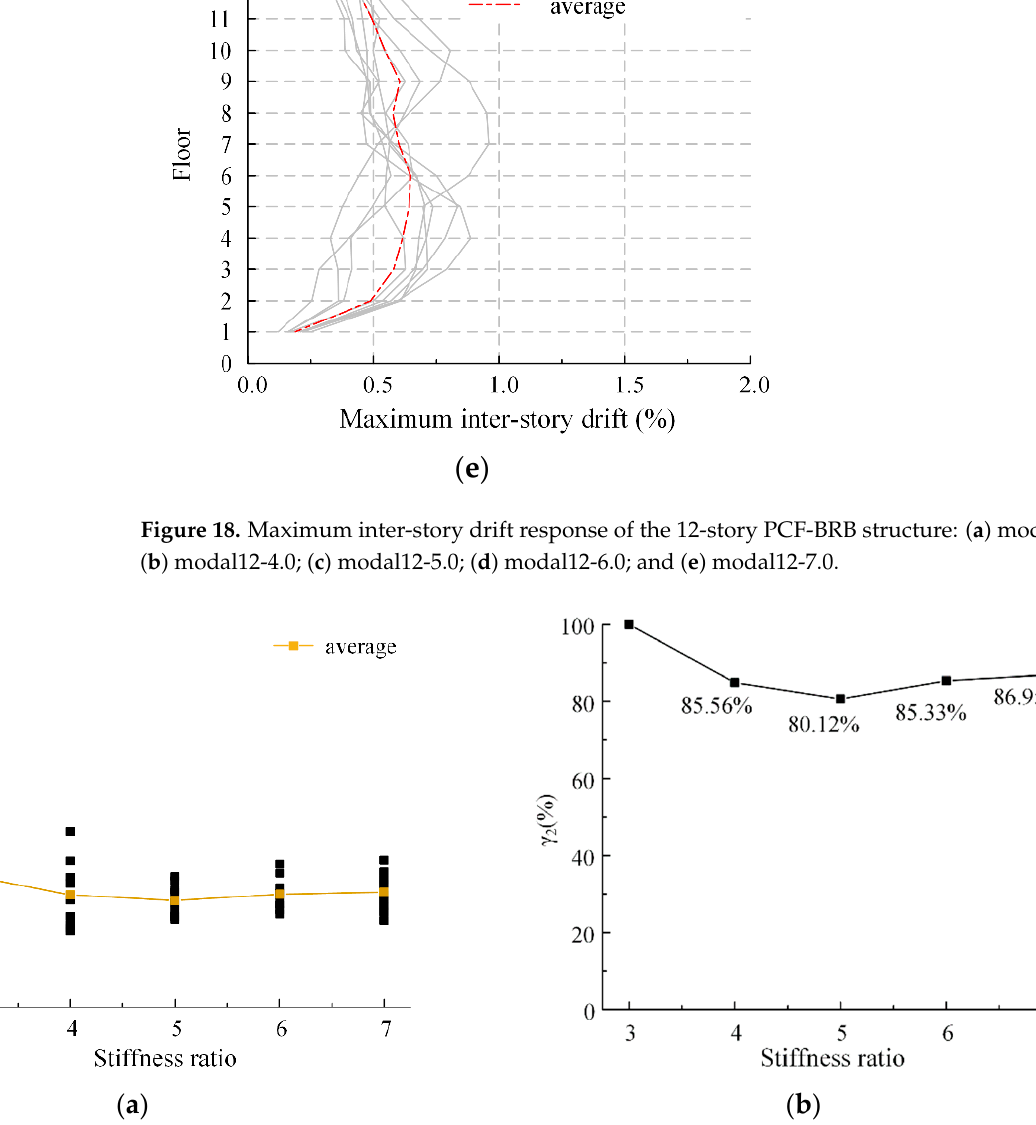
Figure 20. Change of the energy dissipation ratio of BRBs in the four-story PCF-BRB structure.